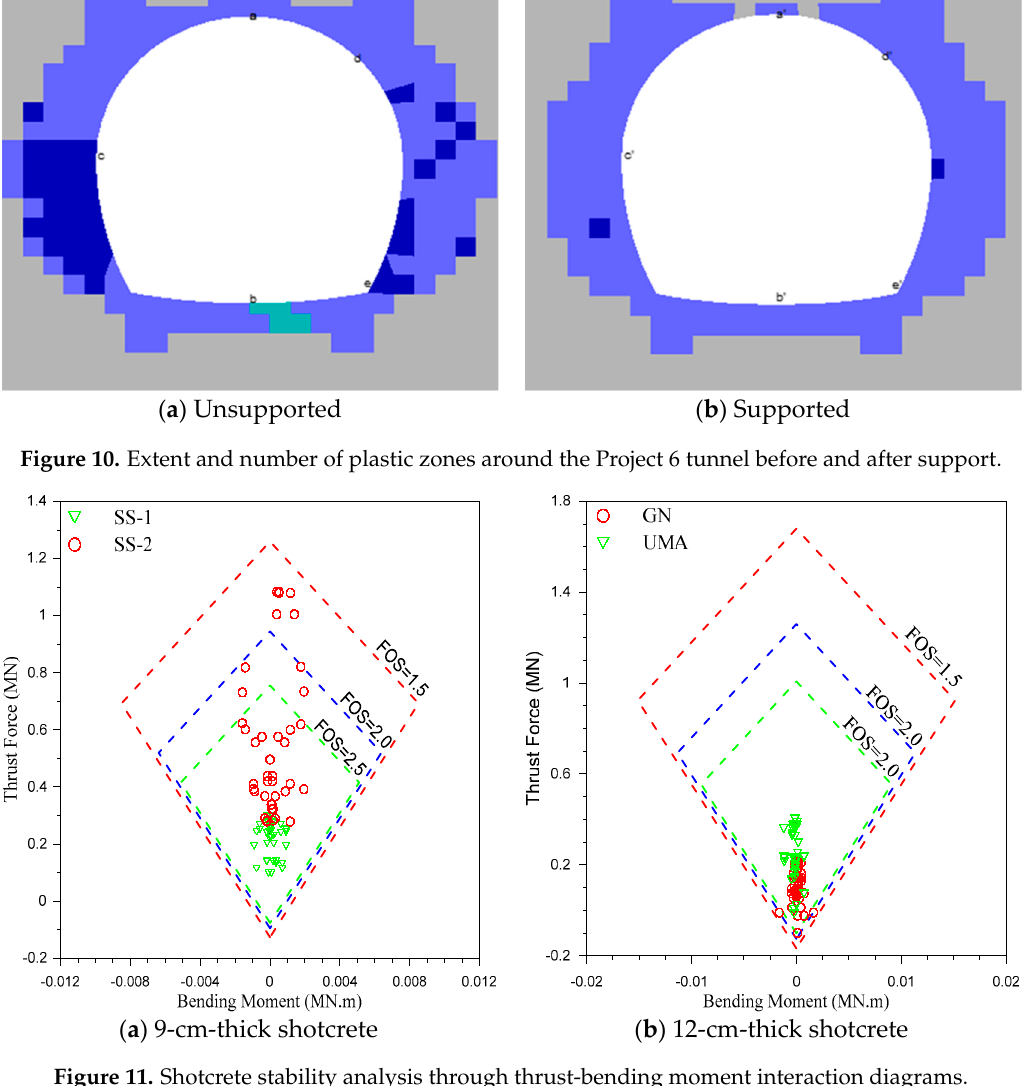
Figure 11. Shotcrete stability analysis through thrust-bending moment interaction diagrams.